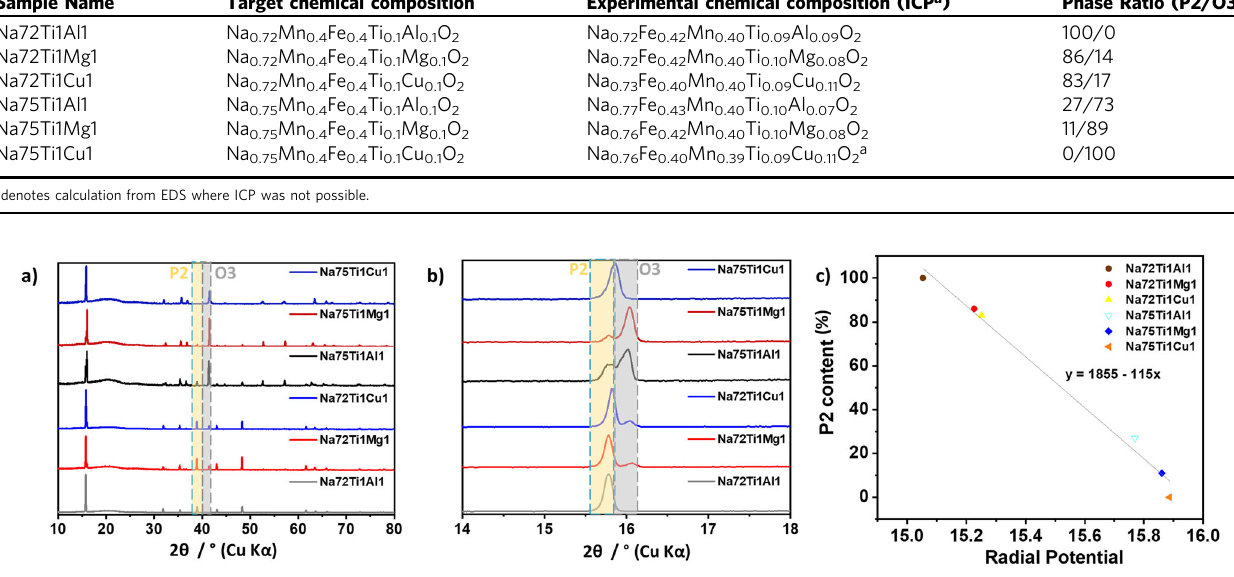
Fig. 2 Powder XRD patterns for sol-gel synthesised materials showing the change in P2:O3 ratio throughout the series. a Powder XRD patterns for the sol-gel synthesised series between 10 – 80 degrees. b Is an expansion of the data shown in a , highlighting the low angle (002) and (003) diffraction peaks, which correspond to the P2 and O3 structures respectively. c Plot of P2 content against radial potential, including a linear fi t where r 2 =